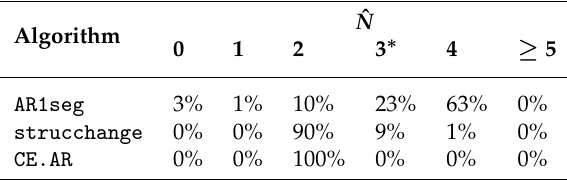
Table 6. Estimated number of multiple change points.